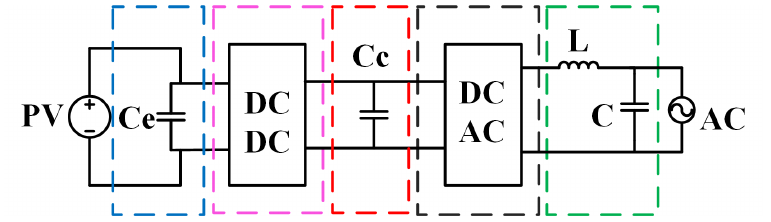
Figure 2. Conventional scheme used for multi-stage PV-connected